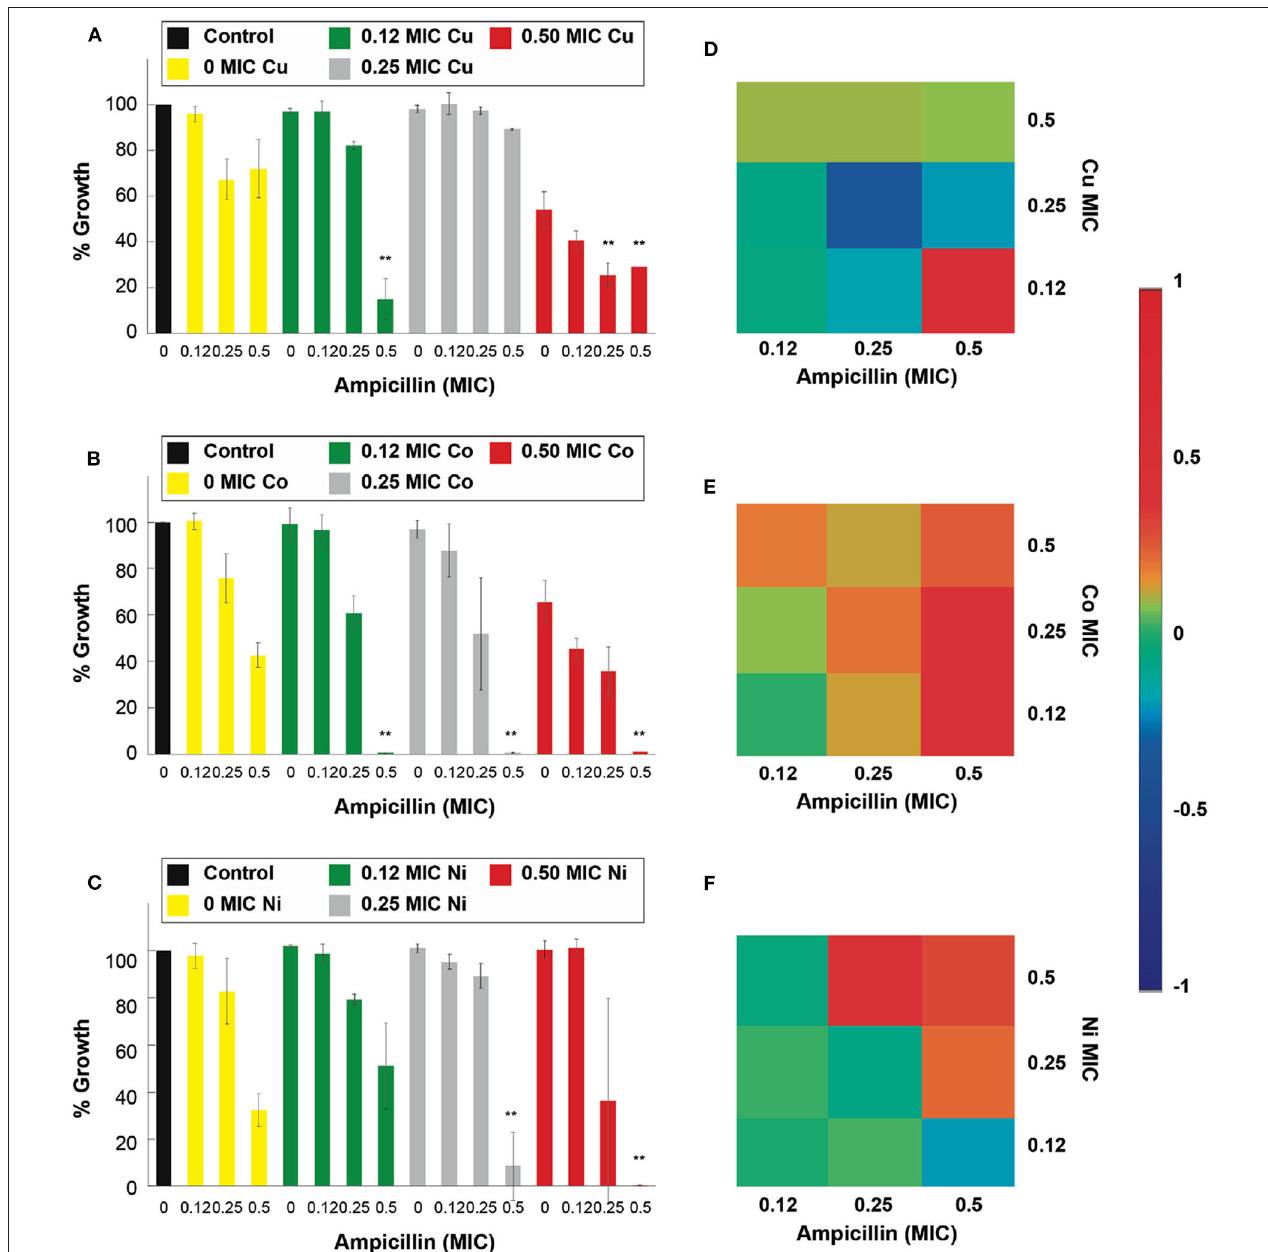
FIGURE 2 | Antimicrobial effect and interactions of ATMCs in E. coli . Growth percentage by sub-inhibitory concentrations of metal ion-antibiotic combinations: (A) Cu 2 + -ampicillin, (B) Co 2 + -ampicillin, and (C) Ni 2 + -ampicillin against E. coli ATCC 11229. Classification of the different interactions between metal ion-antibiotic combinations. The interactions of (D) Cu 2 + -ampicillin, (E) Co 2 + -ampicillin, and (F) Ni 2 + -ampicillin combinations are classified as synergistic, additive or antagonist, value > 0, = 0, and < 0, respectively. Each experiment was done in triplicates. **Corresponds to a significant difference ( p < 0.05) concerning the control and each of the individual treatments. Error bars correspond to the standard deviation from experiments performed in